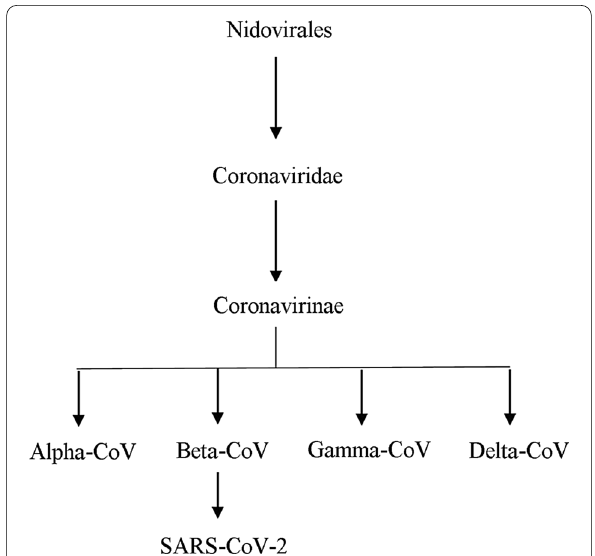
Fig. 1 Hierarchy of Nidovirales